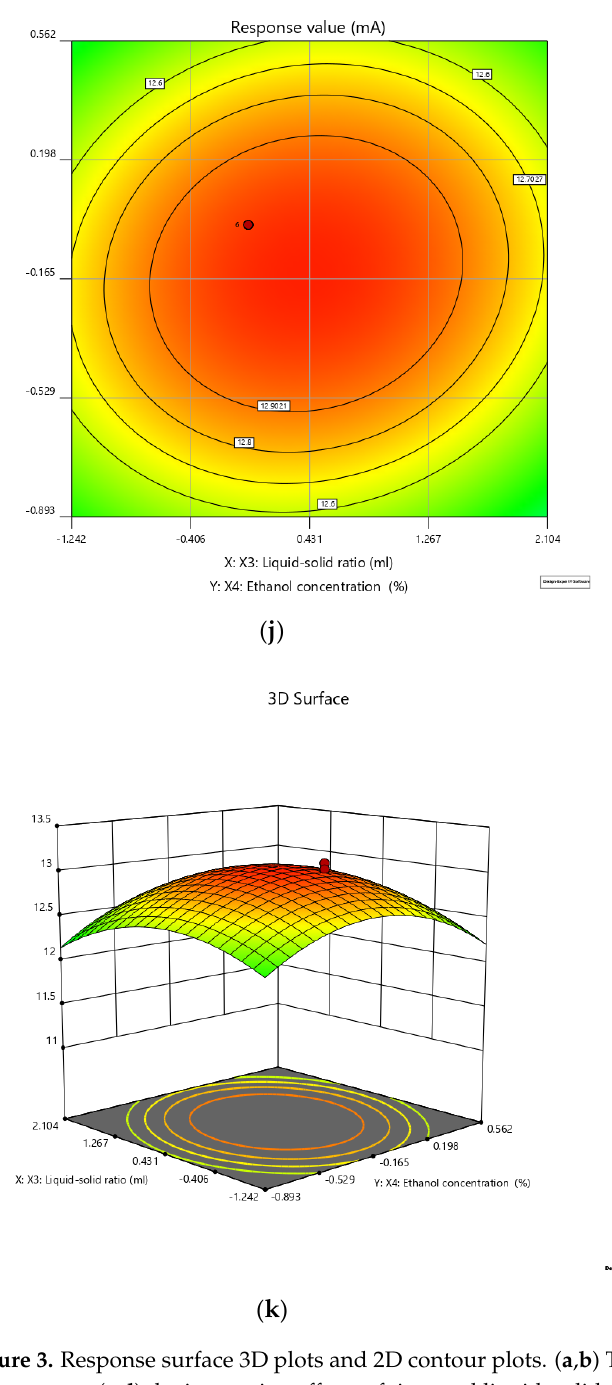
Figure 3. Response surface 3D plots and 2D contour plots. ( a , b ) The interaction effects of time and temperature; ( c , d ) the interaction effects of time and liquid–solid ratio; ( e , f ) the interaction effects of time and ethanol concentration; ( h , i ) the interaction effects of liquid–solid ratio and temperature; ( j , k ) the interaction effects of liquid–solid ratio and ethanol concentration.